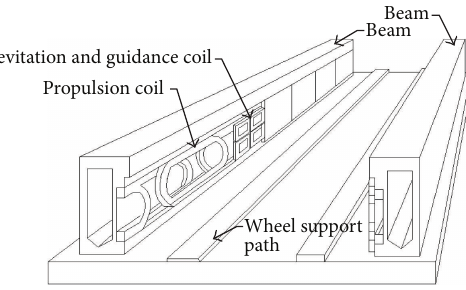
Figure 13: Schematic diagram of EDS maglev